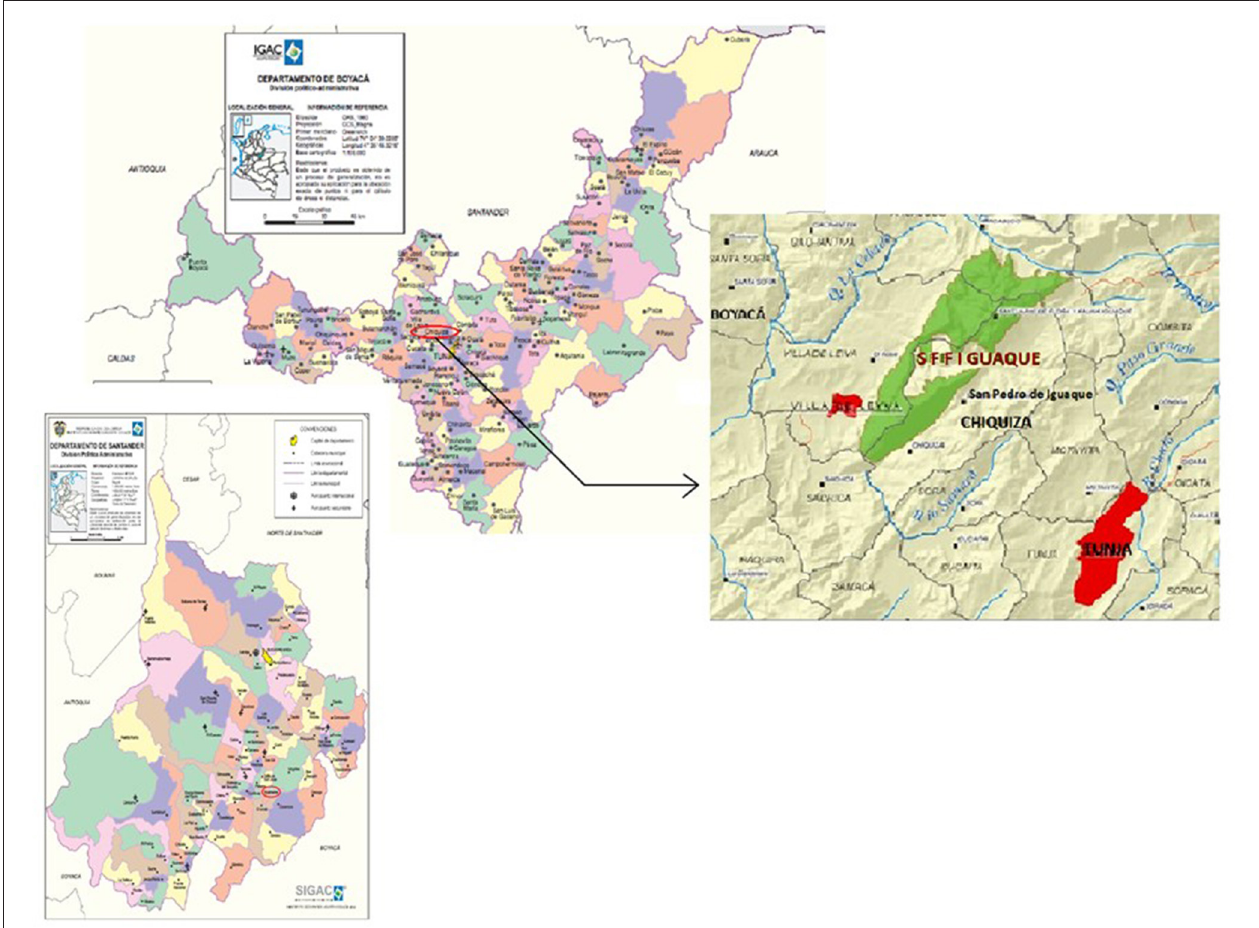
FIGURE 2 | Case study areas in red circles. Sand Pedro de Iguaque (Boyacá—Upper map) and Ocamonte (Santander—Lower map). Upper map also shows the overlap between the municipality of Chíquiza—San Pedro de Iguaque and the Iguaque National Natural Park (SFF Iguaque in